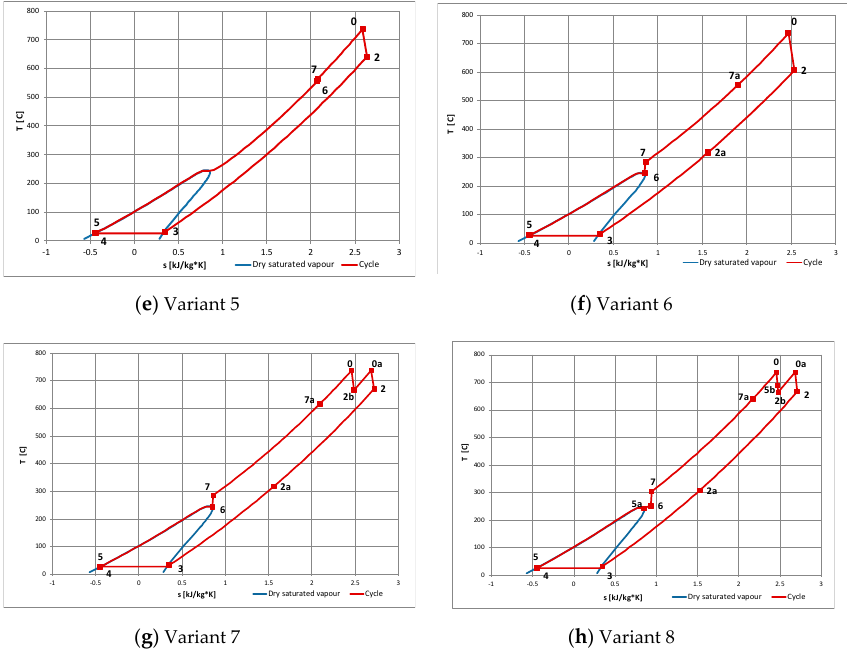
Figure 7. Cycle interpretation in T-s diagram for all analyzed variants (hexamethyldisiloxane (MM)